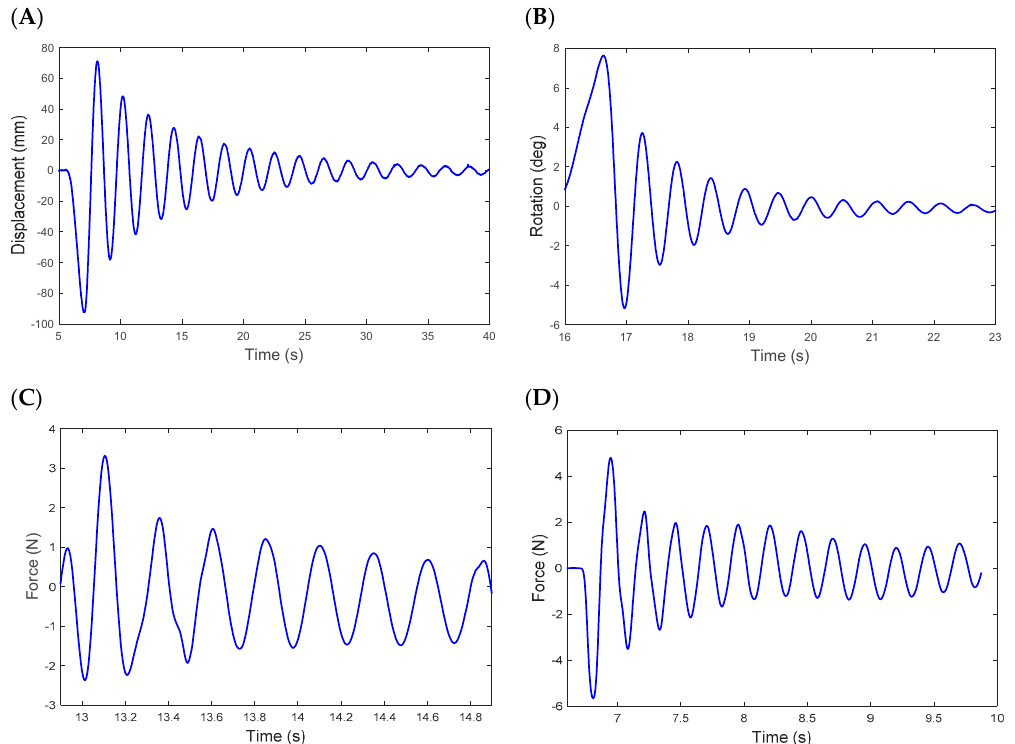
Figure 8. Free decay test results for surge motion ( A ), yaw motion ( B ), heave motion ( C ) and pitch motion ( D ).